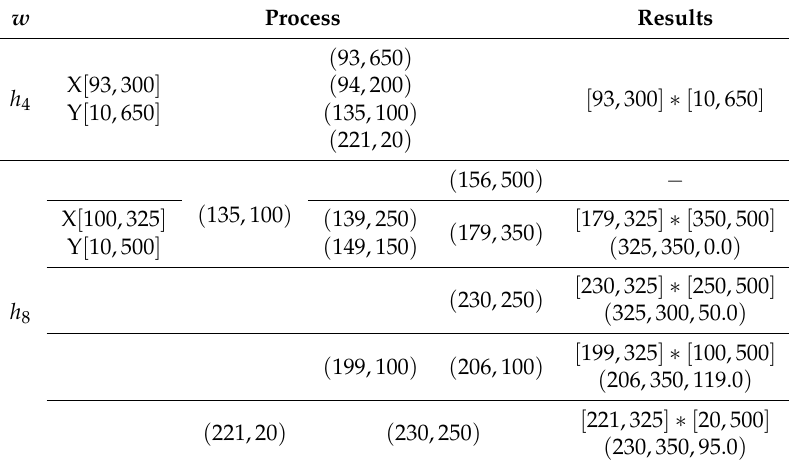
Table 2. Results of MRE+MWR combination algorithm, where w (cid:54)∈ R . ( h 4 = ( 93,650 ) and h 8 = ( 325,350 ) ). w Process